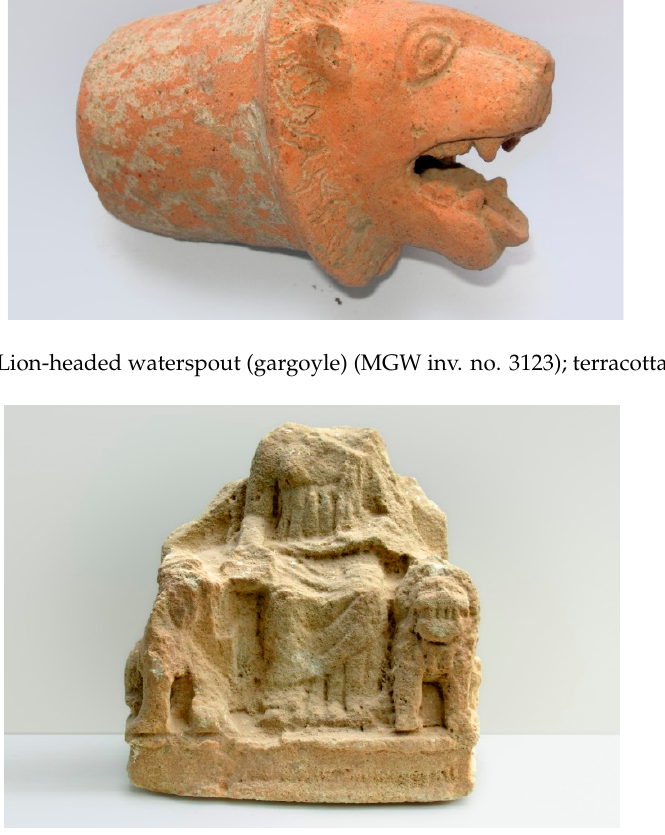
Figure 21. Enthroned Cybele flanked by seated lions (MGW inv. no. 5427); limestone sculpture; ca. 6th–5th century BCE .